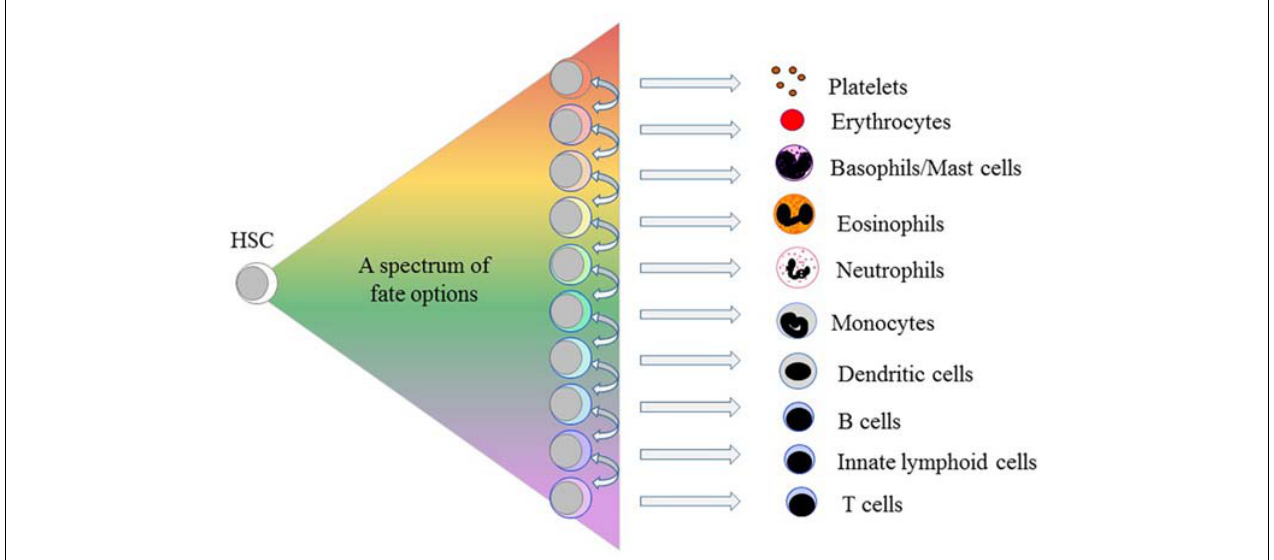
FIGURE 1 | A spectrum of fate options is available to hematopoietic stem cells. By contrast to the progeny of HSCs moving stepwise, through serial fate decisions, to various cell-types each HSC chooses from a spectrum of all of the end cell options. The arrows indicate that for each lineage there are pairwise neighbors in a relatedness hierarchy. HSCs and their progeny remain versatile because having selected a cell lineage they may still “step sideways” to an alternative, albeit closely related, fate(s).